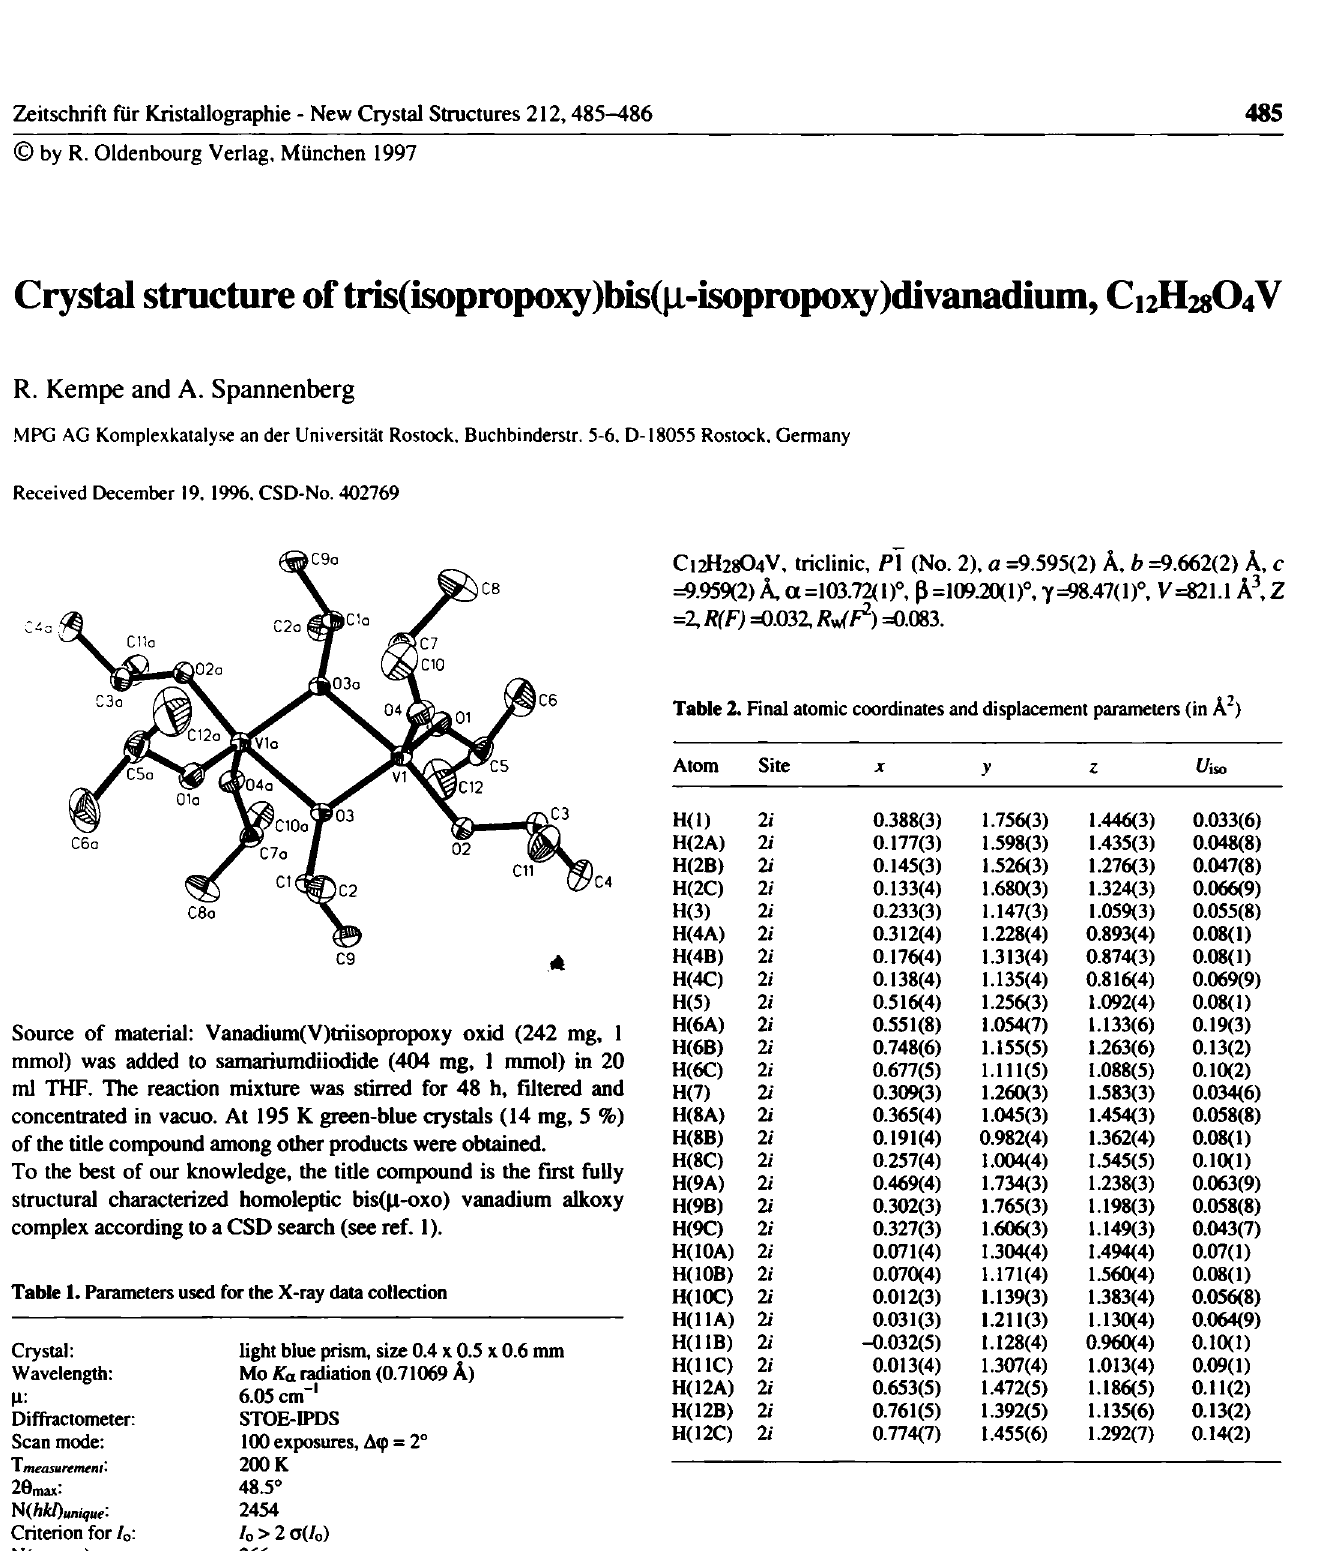
Table 1. Parameters used for the X-ray data collection Crystal: